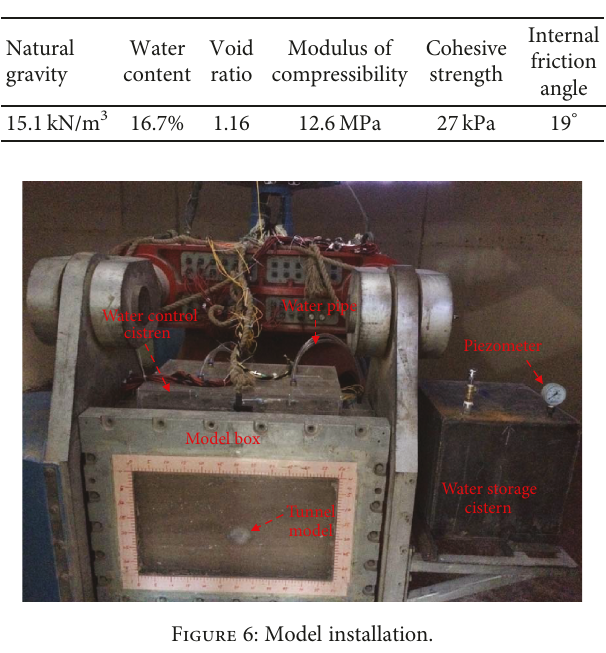
Table 1: Parameters of model soil.